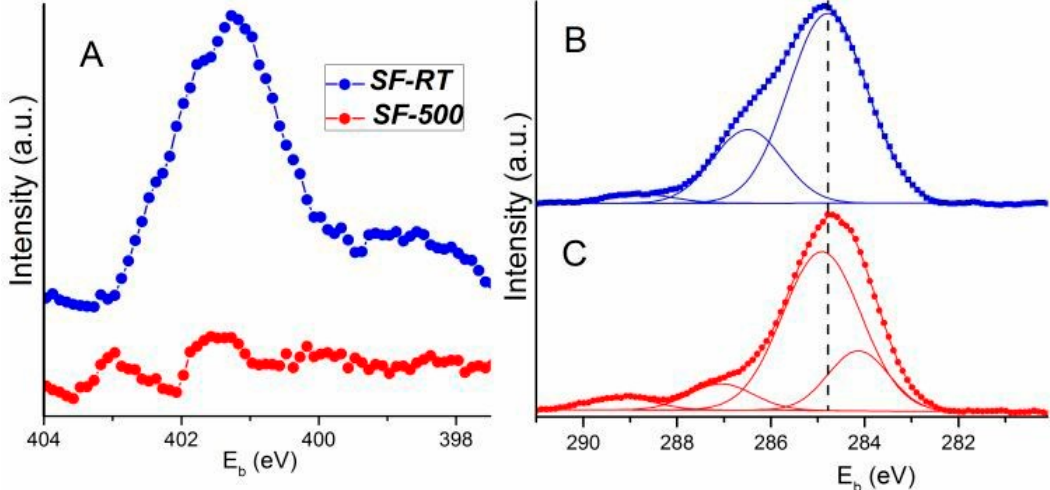
Figure 4. N 1s spectrum of the sample SF-AS (panel A ). Comparison of the line shape of simulated C 1s spectra of the sample SF-AS (panel B ) and SF-500 (panel C ). Table 2. Concentrations of c(N) and c(C) , binding energies E b , and full widths at half maximum (FWHM, in brackets) of photoelectron lines (eV) obtained by simulation of photoelectron spectra.